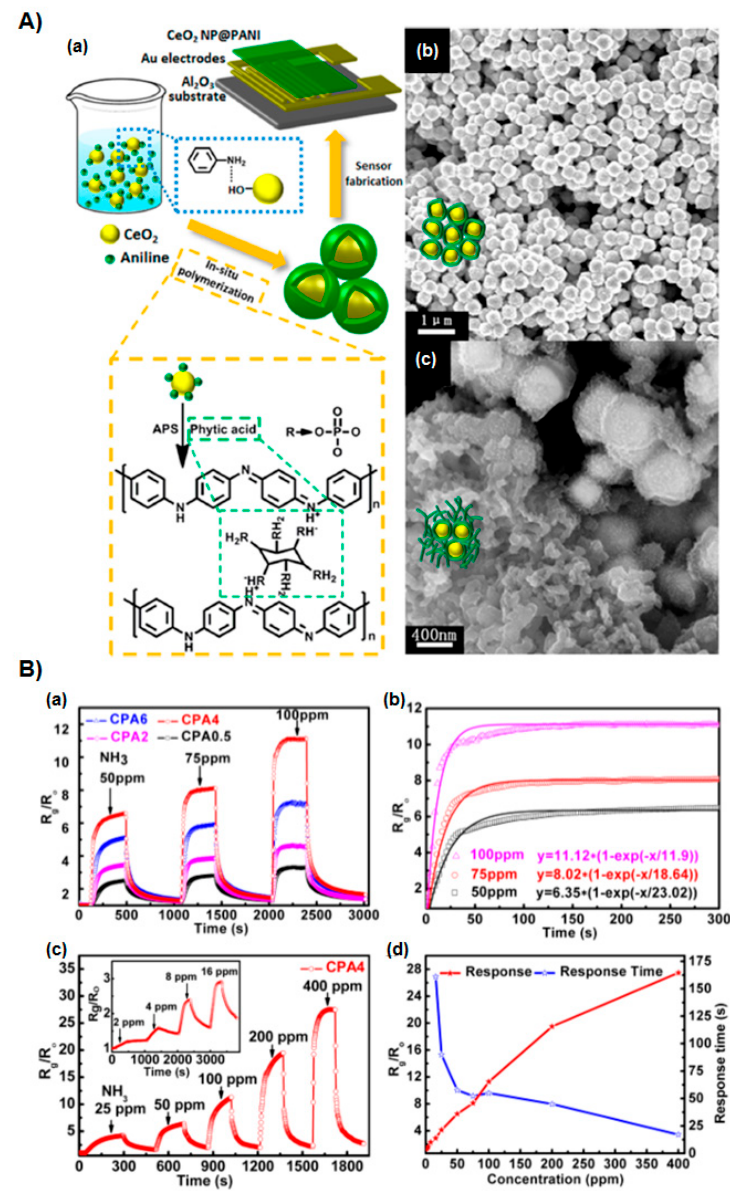
Figure 4. ( A ) ( a ) Schematics of the fabrication of PANI hydrogel/CeO 2 core/shell gas sensors; ( b ) SEM image of CPA4 shows a well-defined core/shell structure in an optimal CeO 2 /aniline ratio; ( c ) SEM image of CPA0.5, which exhibits a three-dimensional network structure through a homogeneously grown PANI hydrogel. ( B ) ( a ) Response curves of CPA0.5 to CPA6 upon sequential exposure of 50, 75, and 100 ppm of NH 3 ; ( b ) fitted curves (solid lines) and experimental results (scattered points) of CPA4 to 50, 75, and 100 ppm of NH 3 ; ( c ) reversible and reproducible responses of CPA4 to di ff erent concentrations of NH 3 . Inset is the transient response of sequential exposure to 2, 4, 8, and 16 ppm of NH 3 . ( d ) Response and response time of CPA4 to various NH 3 concentrations. The feed weight ratio of CeO 2 to aniline was varied as 0.5, 2, 4, and 6, and the resulting composites were denoted as CPA0.5, CPA2, CPA4, and CPA6, respectively. Reprinted with permission from [43]. Copyright 2014, American Chemical Society.